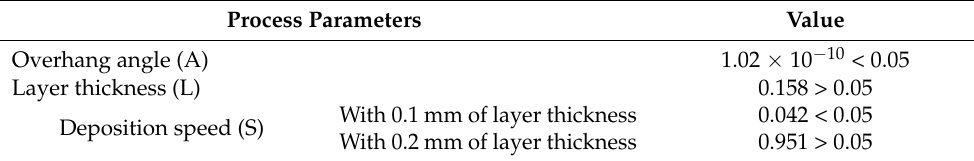
Table 6. Result of one-way ANOVA.